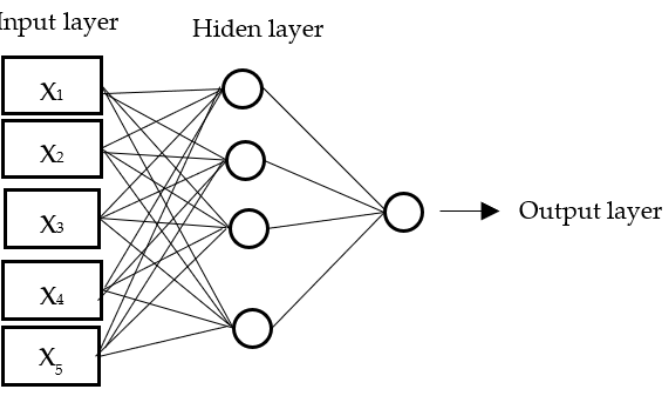
Figure 1. The Multilayer Perceptron structure.